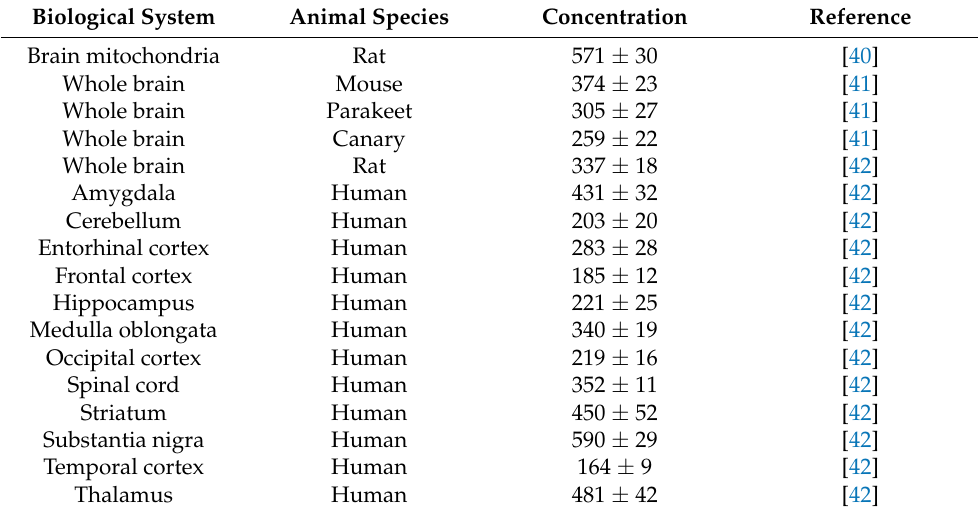
Table 1. Steady-state levels of the advanced lipoxidation end-product malondialdehyde-lysine (MDALys) measured by gas chromatography/mass spectrometry in distinct regions and in whole brains of different animal species, including